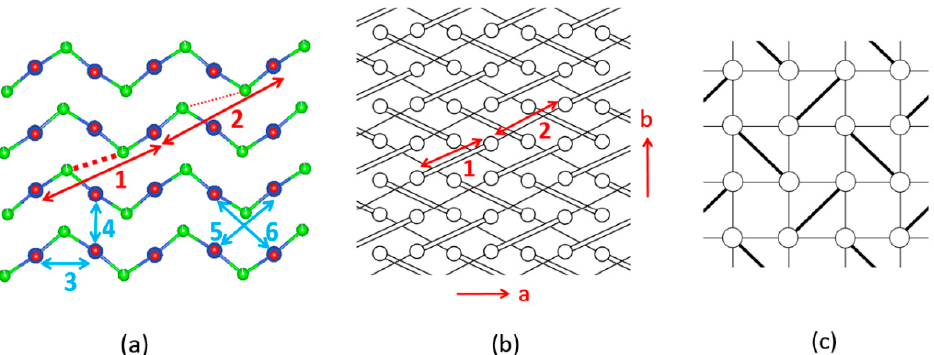
Figure 19. ( a ) Six spin exchange paths of the CuClO 2 layer in orthorhombic CuCl(LaV 2 O 7 ), and the numbers 1–6 refer to J 1 –J 6 , respectively. ( b ) The J 1 –J 2 AFM alternating chains the CuClO 2 layer. Only the Cu 2+ ions are shown as empty circles, with J 1 and J 2 paths represented by cylinders and lines, respectively. ( c ) The simplified spin lattice of the CuClO 2 layer generated by the three strongest spin exchanges, which is the Shastry–Sutherland spin lattice.